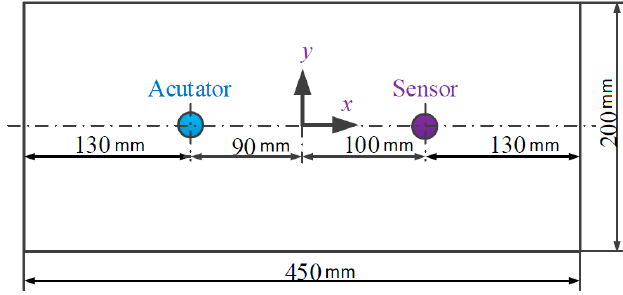
Figure 5. Structural parameters of the aluminum plate.